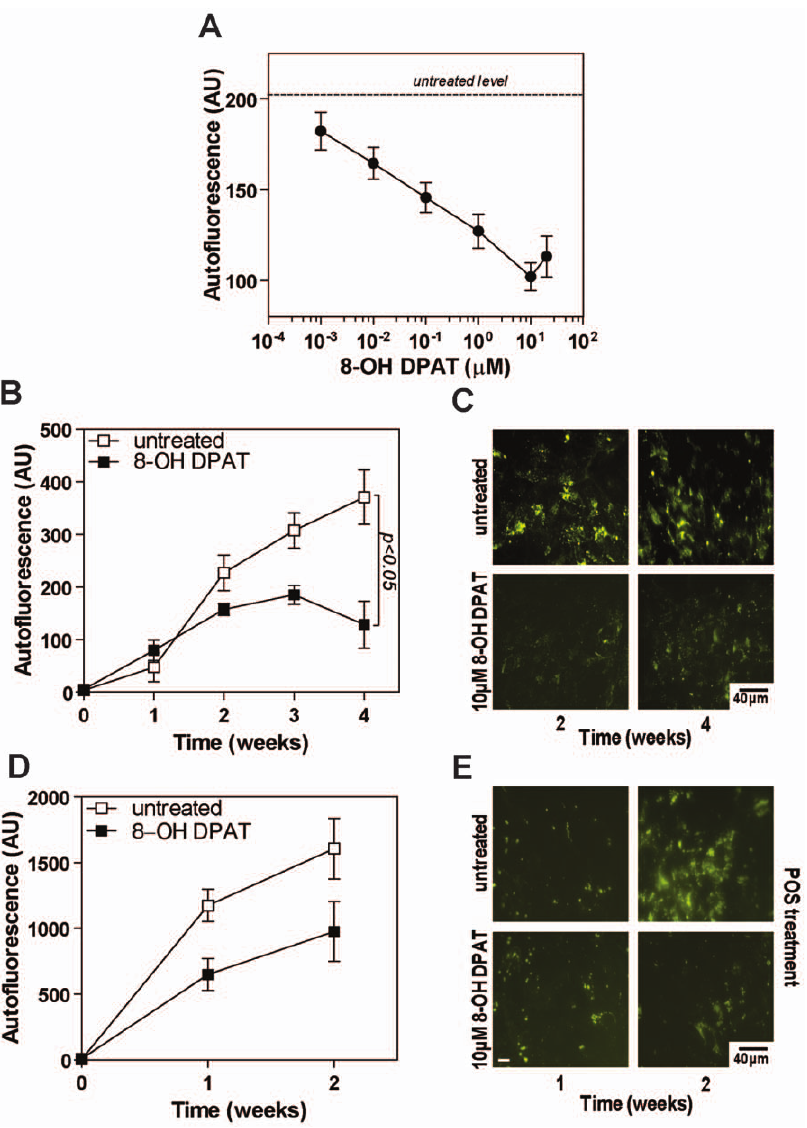
Figure 1. 8-OH DPAT reduces lipofuscin accumulation in cultured RPE cells. A - The effect of different concentrations of 8-OH DPAT on lipofuscin accumulation from autophagy in human ARPE19 cells. Cells were maintained in basal medium and received 10 m M 8-OH DPAT every two days for four weeks. B - Autofluorescent intensity of ARPE19 cells treated with 10 m M 8-OH DPAT every two days for up to 4 weeks. Control cells received vehicle alone. C - Fluorescent micrographs of ARPE19 cells as described in B showing reduced lipofuscin granules in 8-OH DPAT treated cells compared to controls. D - Autofluorescent intensity of ARPE19 cells fed POS treated with 10 m M 8-OH DPAT every two days for up to 14 days. Control cells received POS and saline vehicle alone. E - Fluorescent micrographs of ARPE19 cells described in D showing reduced lipofuscin granule accumulation in 8-OH DPAT treated cells fed POS compared to untreated controls. Fluorescence intensity was determined by flow cytometric analysis. Data represent the mean of three experiments. Bar marker is 50 m